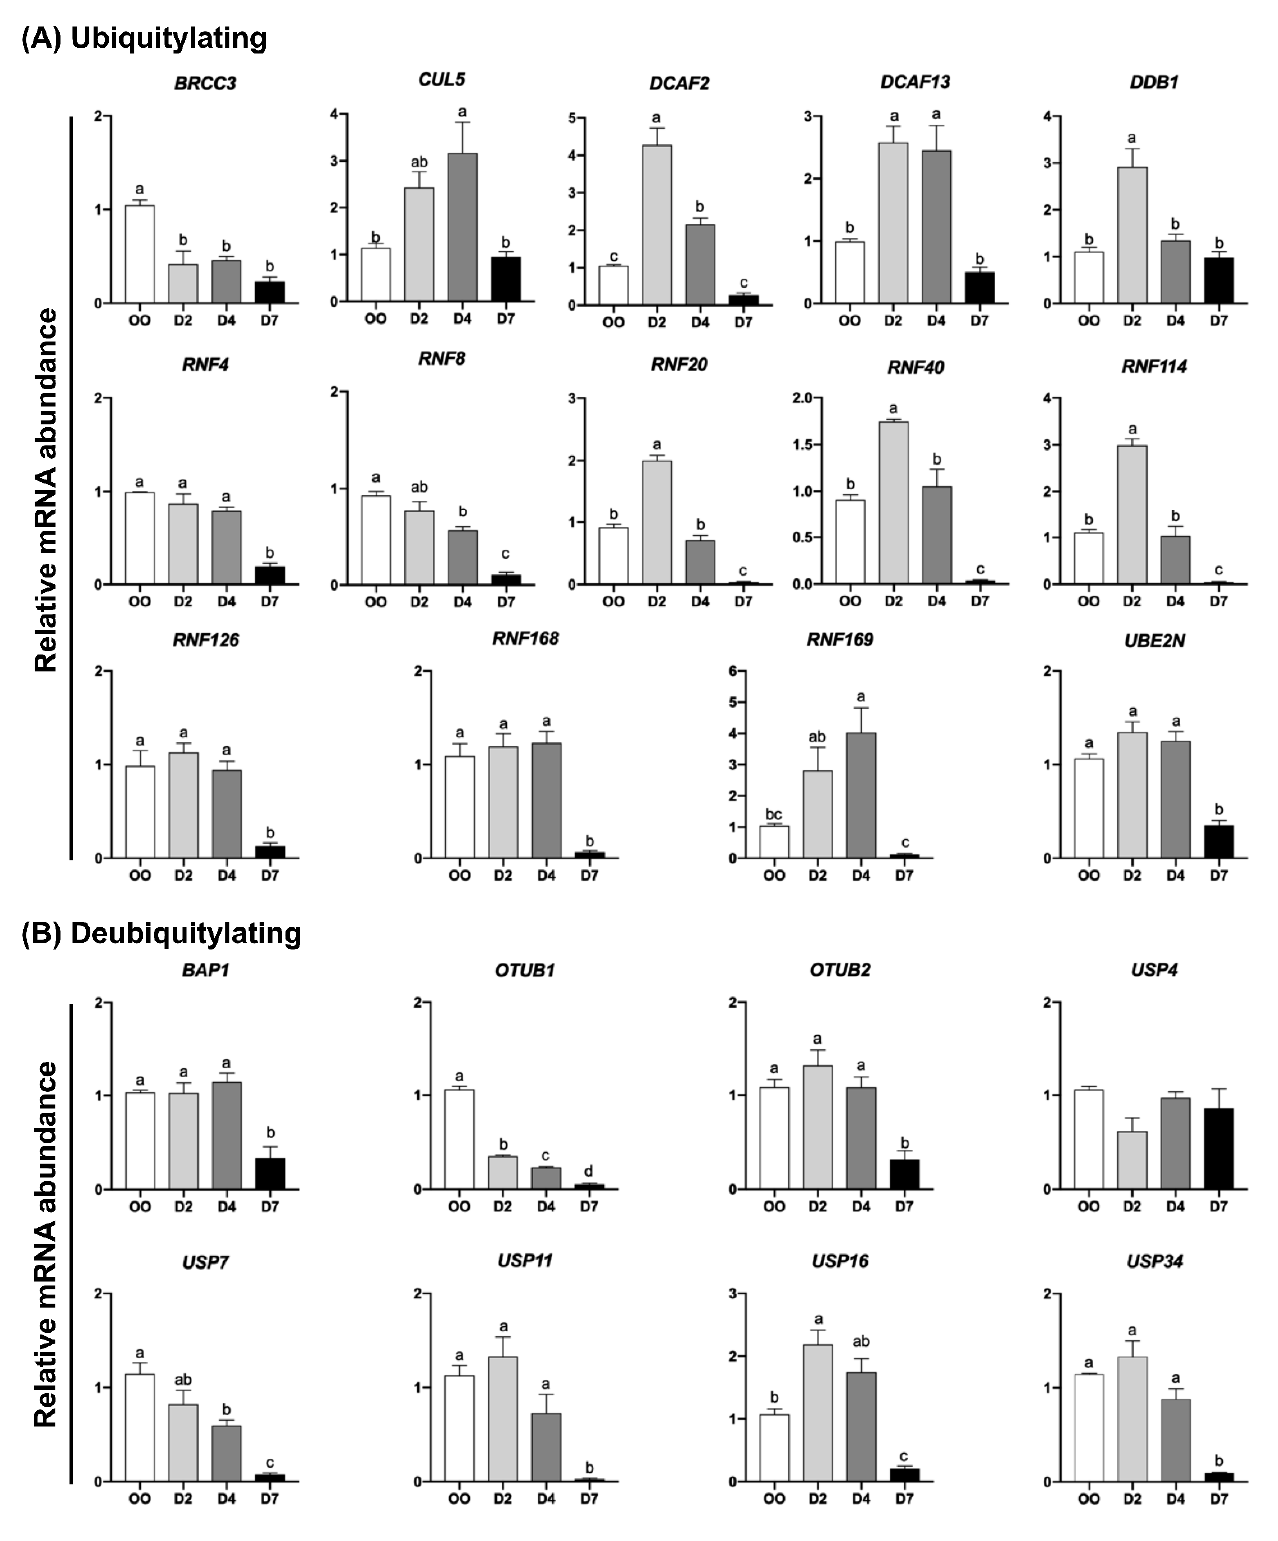
Figure 2. Relative mRNA abundance of genes encoding ubiquitylation ( A ) and deubiquitylation ( B ) enzymes in porcine oocytes and embryos at different stages of development. OO, MII oocytes; D2, day 2 embryos; D4, day 4 embryos; D7, day 7 blastocysts. Different letters indicate statistical differences ( p < 0.05) between developmental stages.